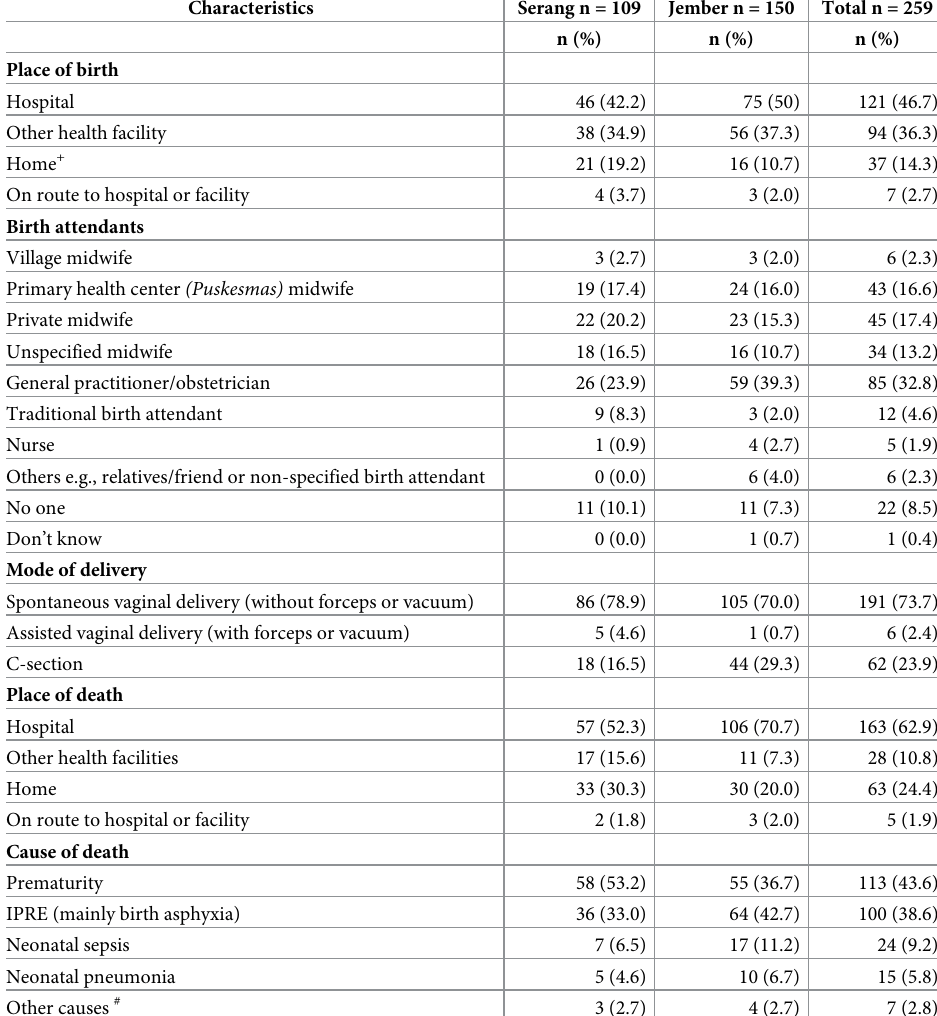
Table 3. Birth characteristics, place, and cause of death.